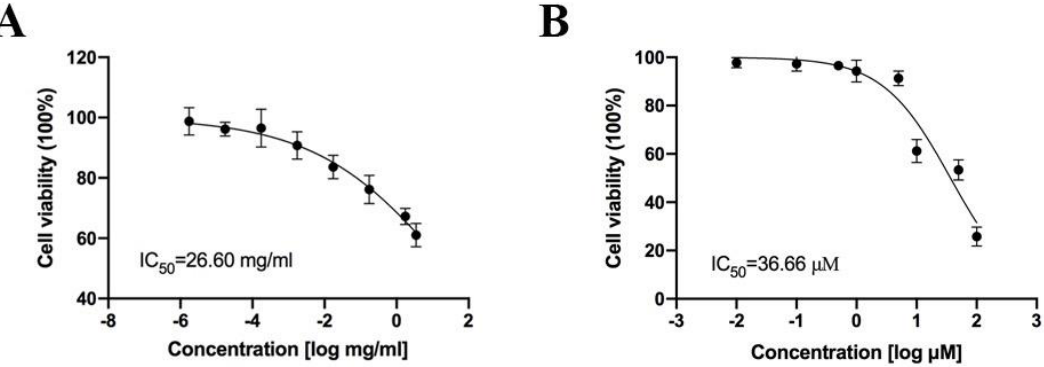
Figure 4. Effects of cell toxicity were assessed via CCK8 assay (( A ): the viability of CHO cells was determined after treatment with the indicated concentrations of total alkaloids for 24 h; ( B ): the viability of CHO cells was determined after treatment with the indicated concentrations of neferine for 24 h, and the IC 50 values were determined).